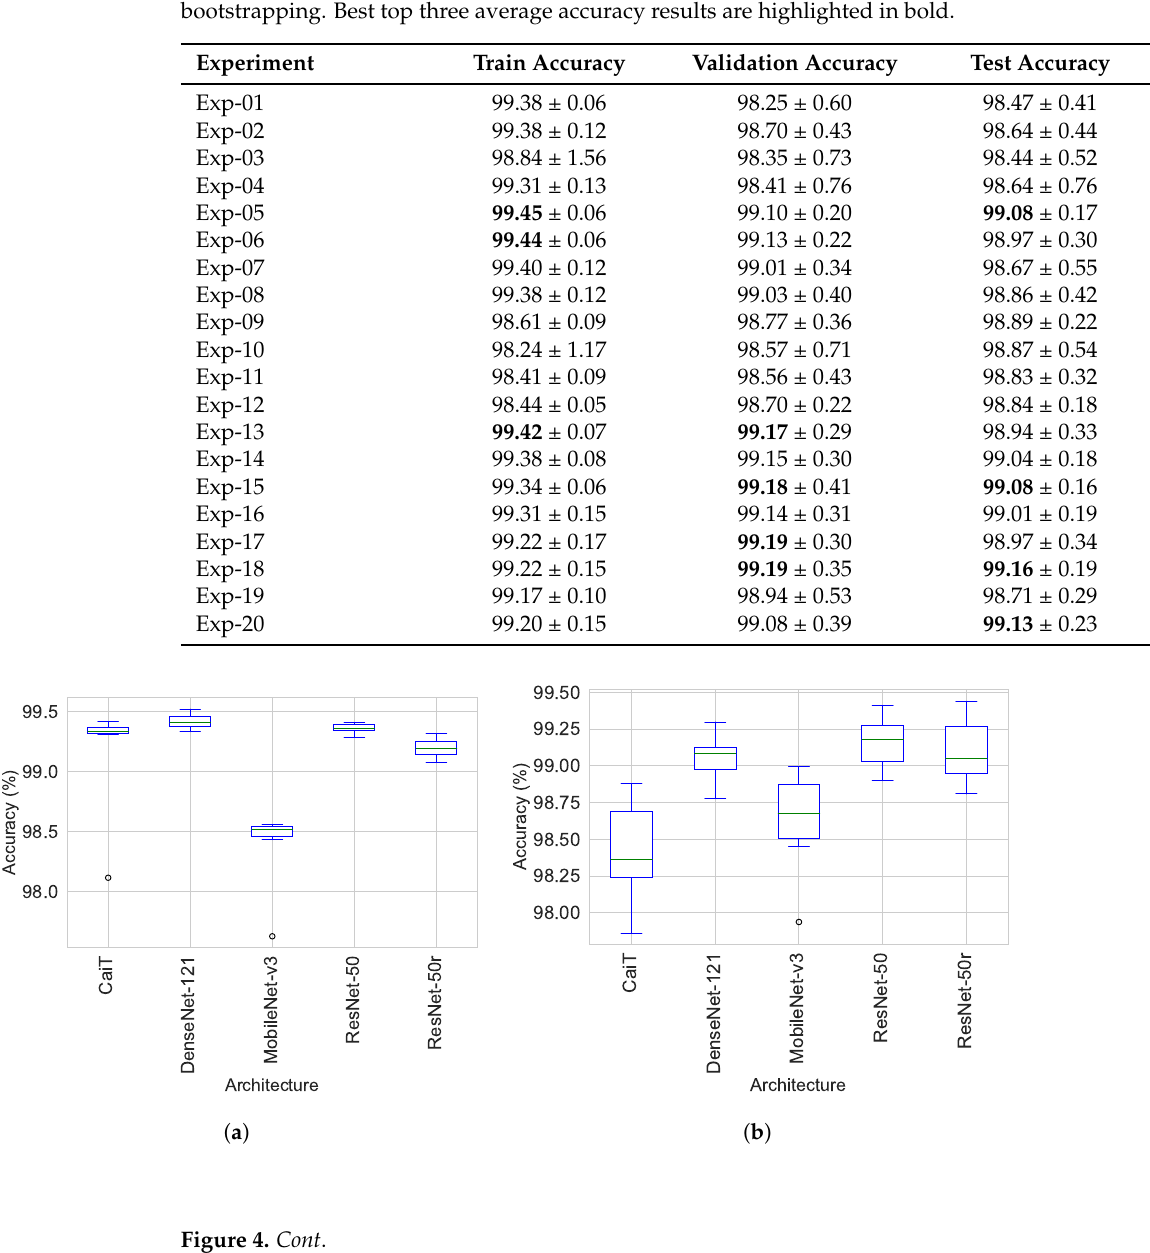
Table 5. Train, validation and test average accuracy and standard deviation by experiment before bootstrapping. Best top three average accuracy results are highlighted in bold.